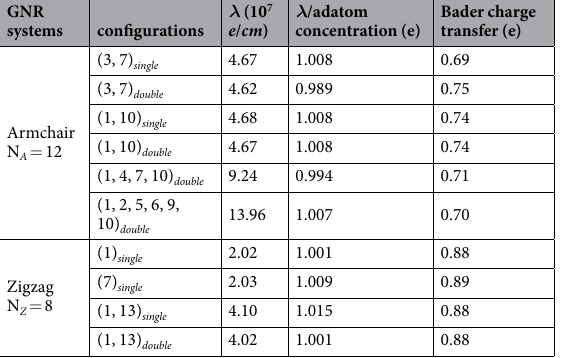
Table 2. Free electron densities for various numbers and positions of adatoms in N A = 12 and N z = 8 alkali- adsorbed